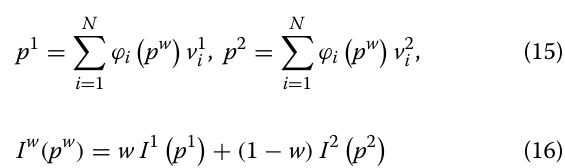
Table 1 Comparison of the multivariate Gaussian mixture (MGM), Gaussian mixture (GM), and Gaussian segmentation energies in the CAC with other existing related methods Method